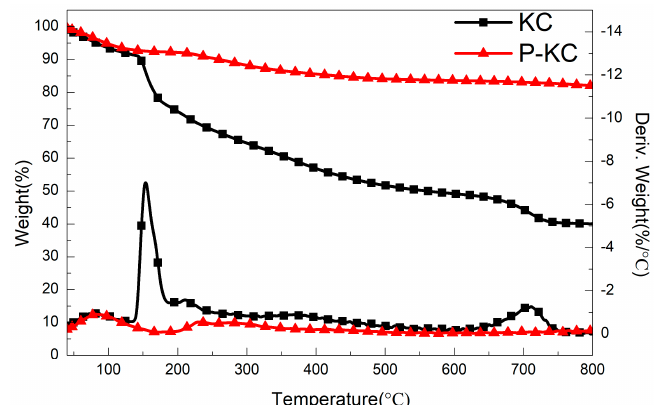
Figure 4. Thermogravimetric analysis and DTG curves of KC and P-KC under N 2 . (The top two lines belong to the left y-axis; the bottom two lines belong to the right y-axis).